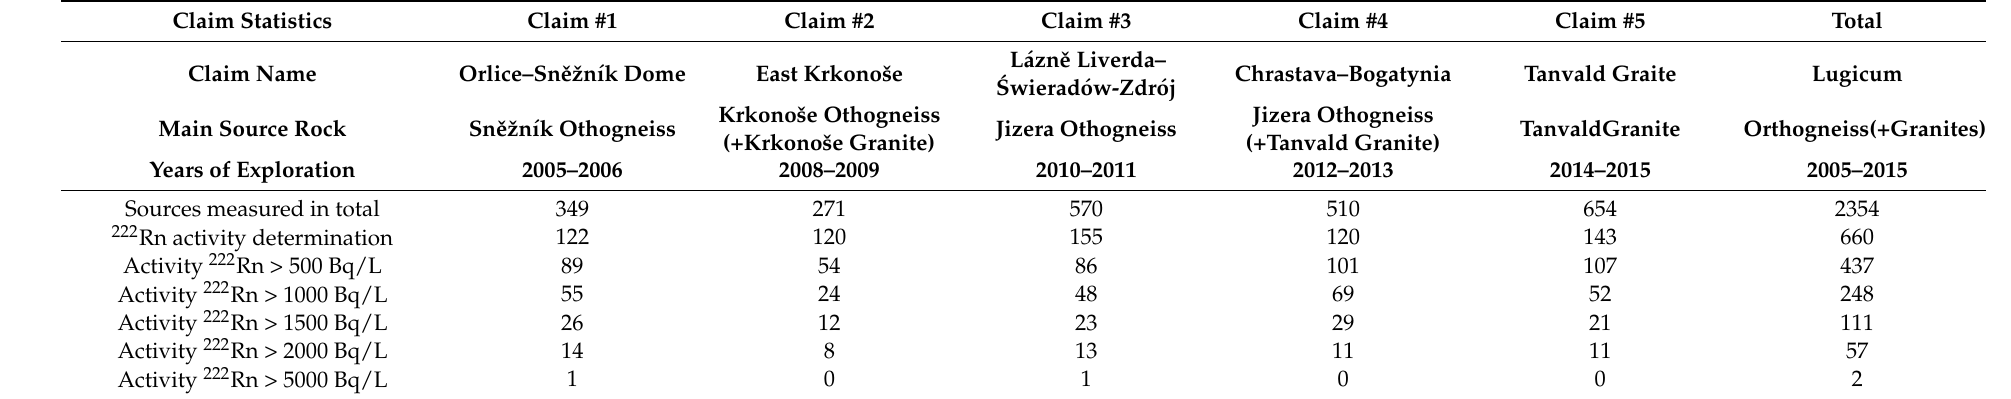
Table 1. Summarized data on the number of measured water outflows and cumulative numbers of objects exceeding the given radon activity in the whole Lugian area.